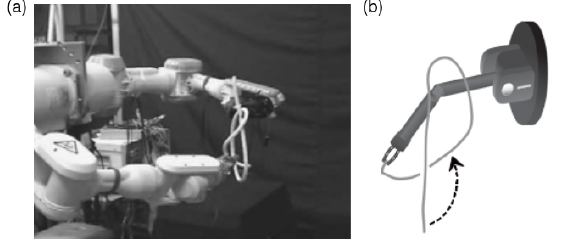
Figure 6. Different knot-tying tasks: ( a ) overhand knot in air by Matsuno et al. (2006) [285] and ( b ) overhand knot with dynamic control by Yamakawa et al. (2010) [52]. Figures reproduced with